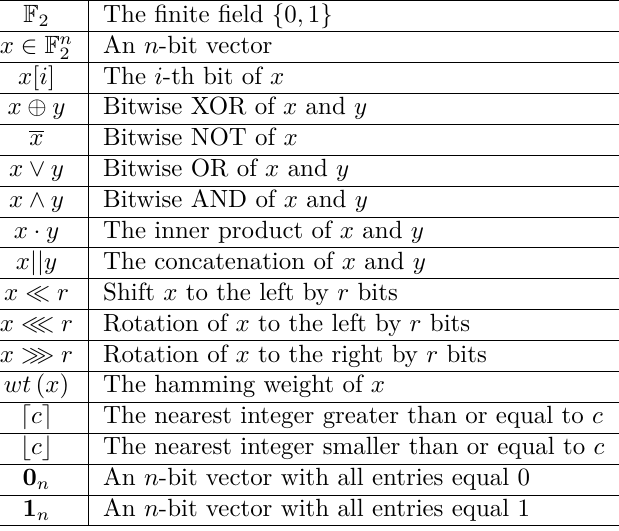
Table 2: Notations used in this